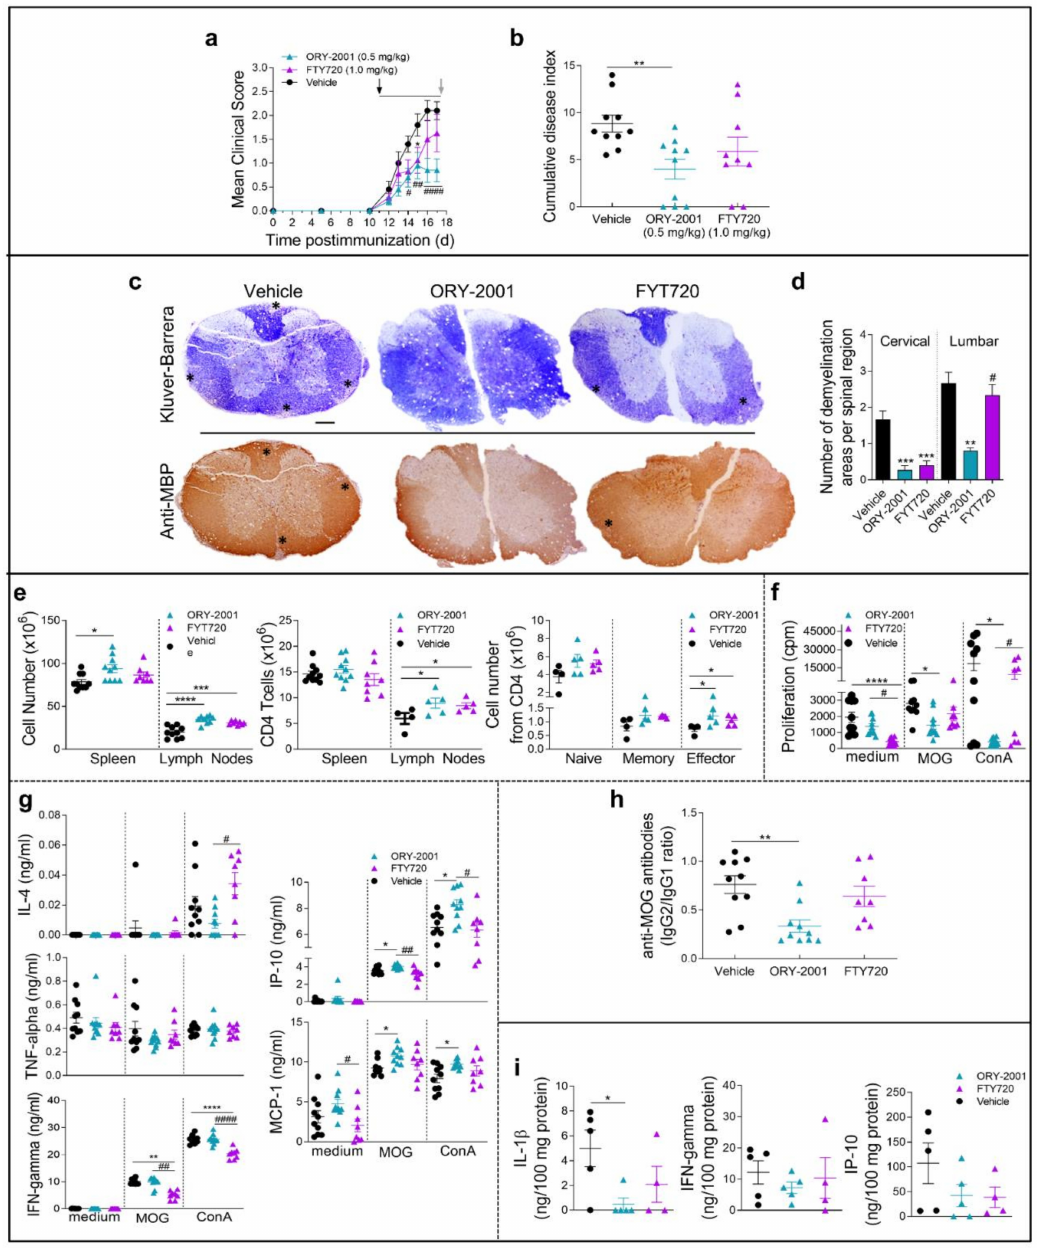
Figure 6. A comparison of the effects of ORY-2001 and FTY720 in EAE mice. Mice with MOG 35–55 - induced chronic EAE were orally treated with vehicle, ORY-2001 (0.5 mg/kg) or FTY720 (1.0 mg/kg) for five consecutive days (horizontal bar in a) starting at the onset of EAE on day 12 (pointed by a black arrow, ( a )). Mean clinical score ( a ) and cumulative disease index ( b ) are showed for each